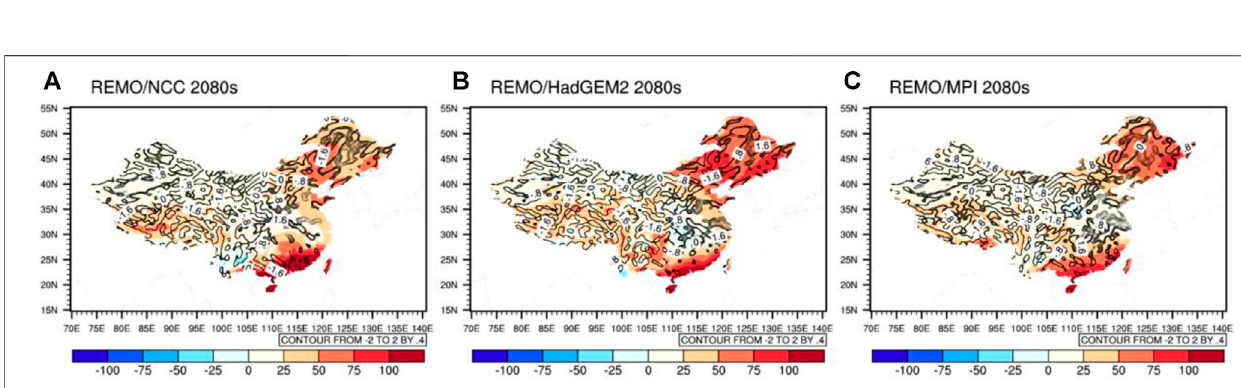
Frontiers in Earth Science |